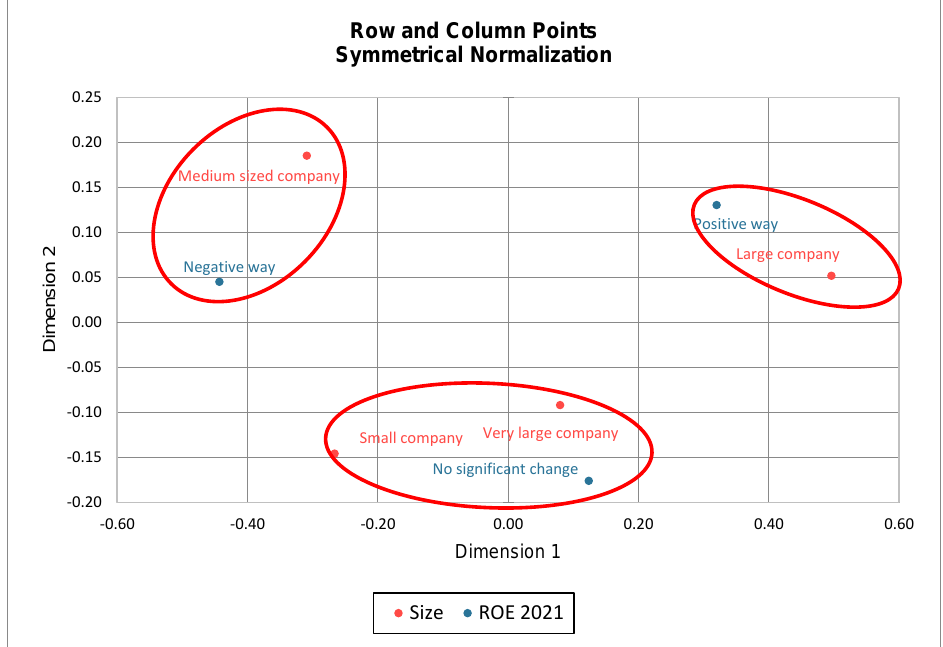
Figure 11. Correspondence map for ROE indicators in 2021 and enterprise size categories. Source: own research.